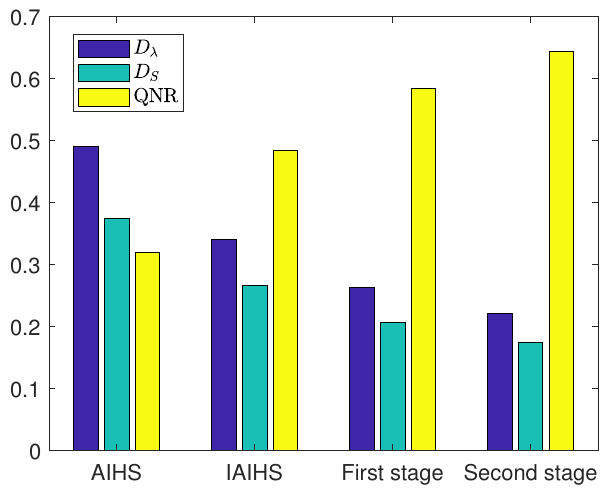
Figure 3. Comparative results of three indicators D λ , D s , and QNR. To better illustrate the model in this paper, the flow chart of the algorithm is given in Figure 4, where ω one and ω two are different weighting functions, as detailed in Algorithm 1. k k